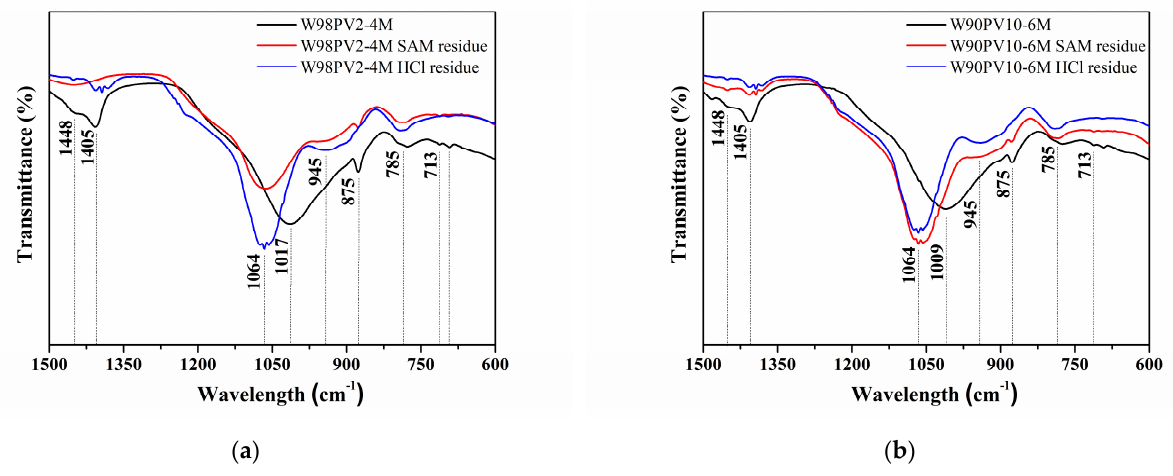
Figure 7. FT-IR spectra after selective chemical extractions: ( a ) W98PV2-4M sample and ( b ) W90PV10-6M sample. SEM micrographs obtained in the backscattered electron (BSE) mode of the W98PV2-4M